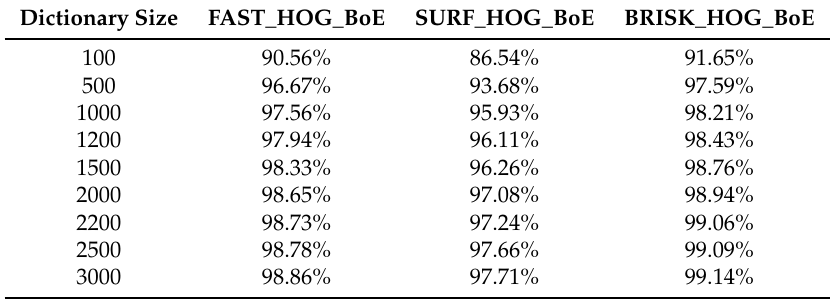
Table 2. Impact of varying dictionary size on average accuracy with FAST, BRISK and SURF feature detectors (using Mahalanobis and sparse-random combination).